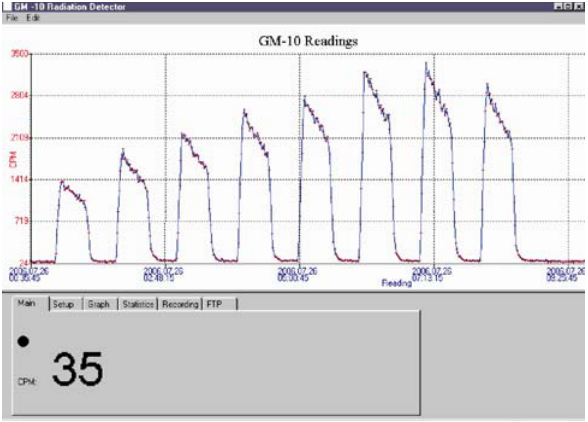
Fig 6. Indoor radon progeny volumetric activity in air du- ring 24 hours